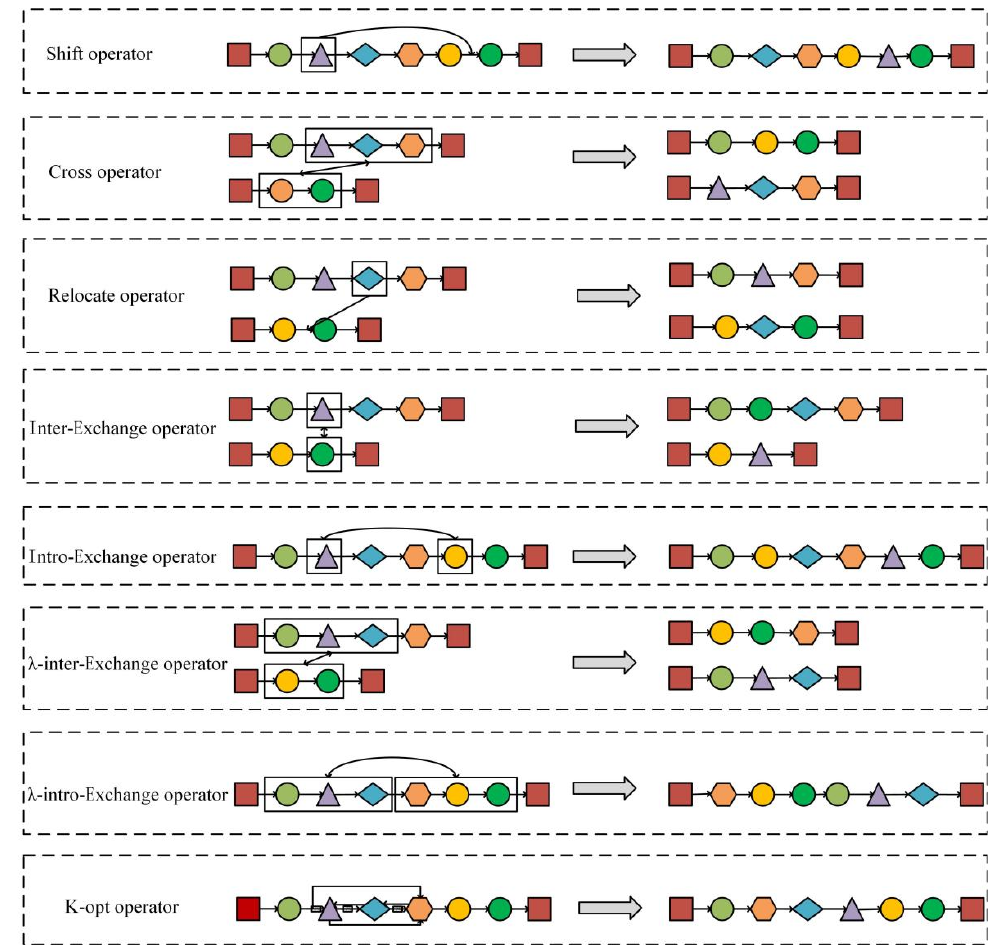
Figure 3. The operation processes of neighborhood search operators.